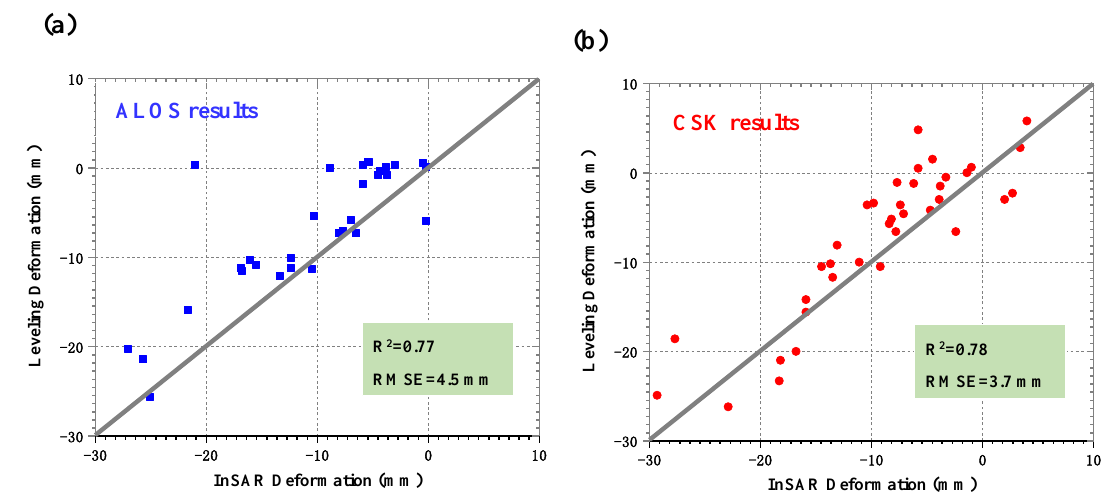
Figure 7. Comparison of annual deformation velocity between leveling and InSAR from ( a ) the L-band ALOS-1 and ( b ) the X-band COSMO-SkyMed.